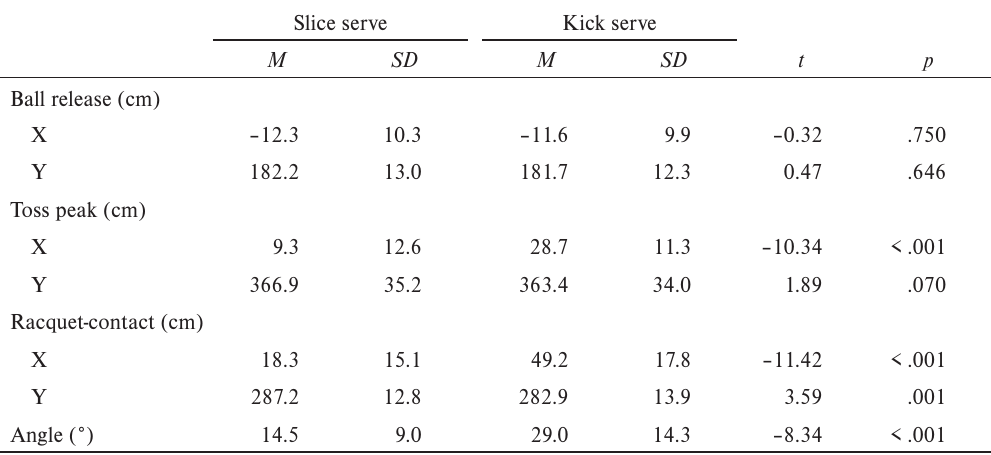
Ball toss kinematics of slice serve and kick serve – deuce court Slice serve